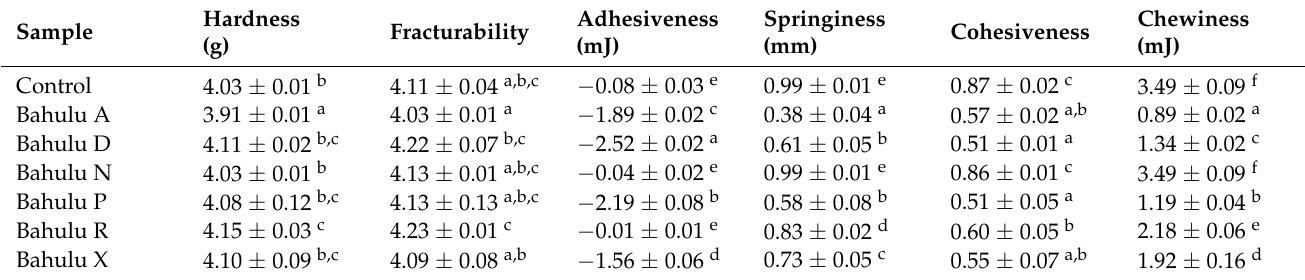
Table 5. Texture profile analysis of Bahulu.